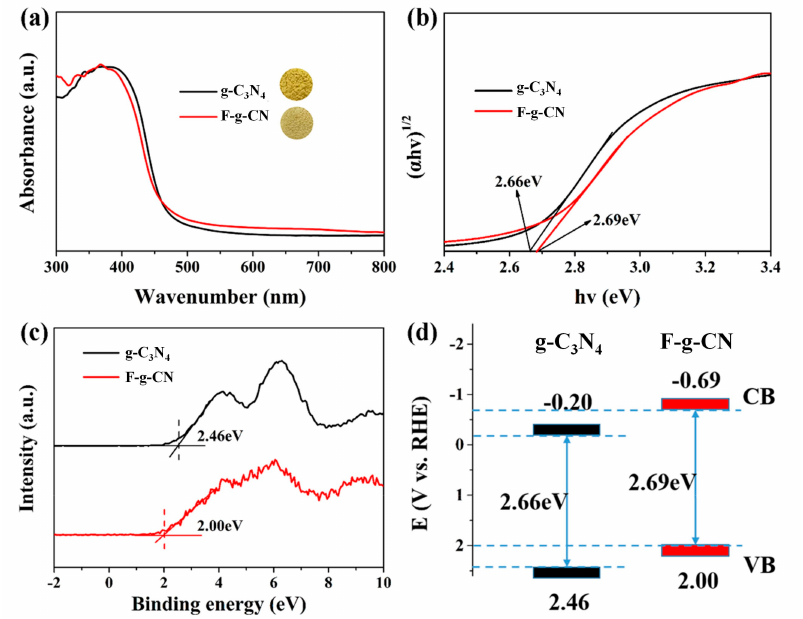
Figure 5. ( a ) UV-Vis absorption spectra of g-C 3 N 4 and F-g-CN and ( b ) their corresponding bandgaps. ( c ) VB XPS spectra of g-C 3 N 4 and F-g-CN. ( d ) Schematic illustration of the g-C 3 N 4 and F-g-CN band